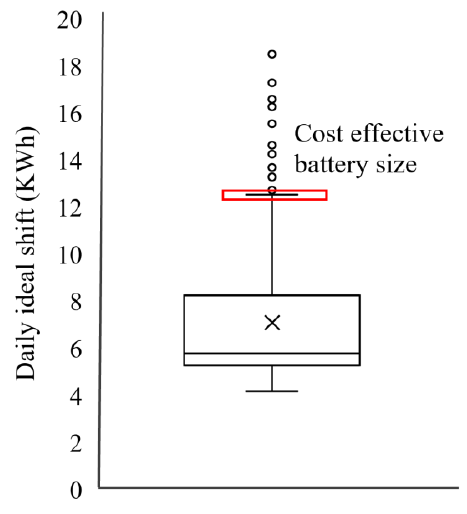
Figure 5. Illustration of determining the cost-effective battery sizing for a typical